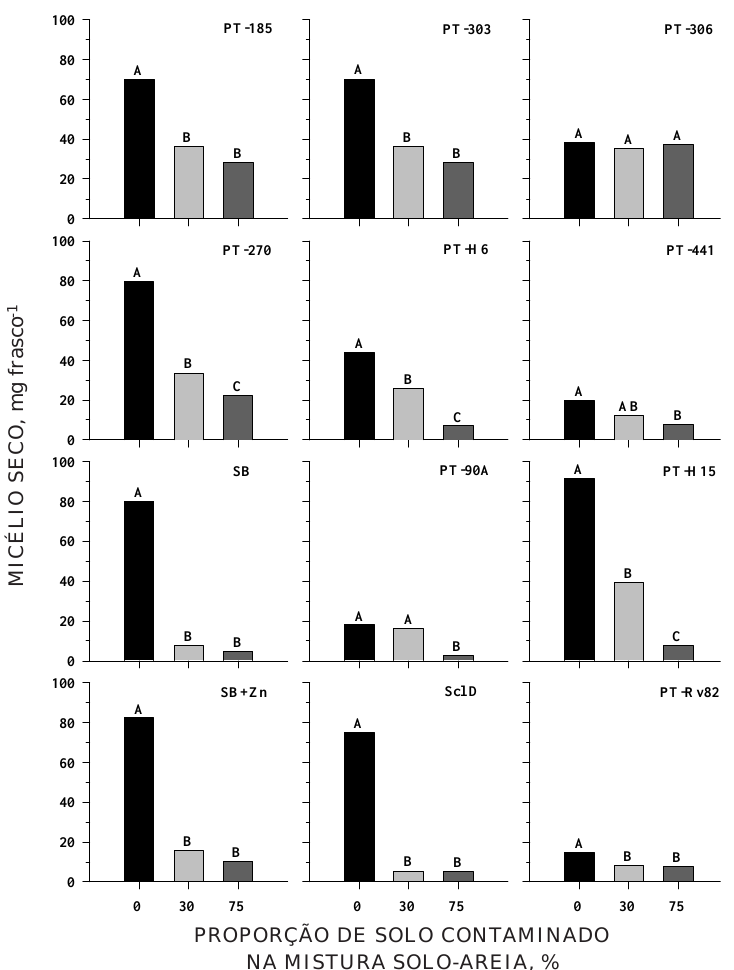
Figura 1. Produção de massa seca de micélio de isolados de Pisolithus tinctorius , Suillus bovinus e Scleroderma sp. em meio MNM que continha mistura de solo e areia com diferentes proporções de solo contaminado. Para cada isolado, as barras com letras diferentes diferem entre si, a 5% pelo teste de